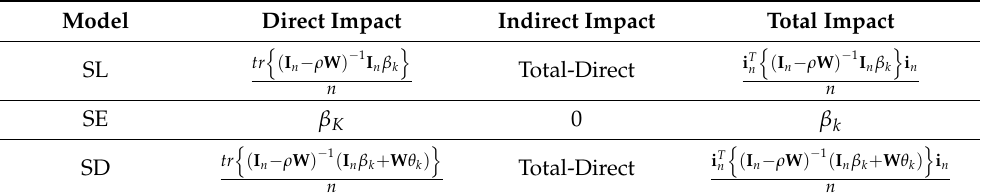
Table 3. Total, direct, and indirect impacts on the response variable resulting from a change in covariates: Spatial-PD-STIRPAT